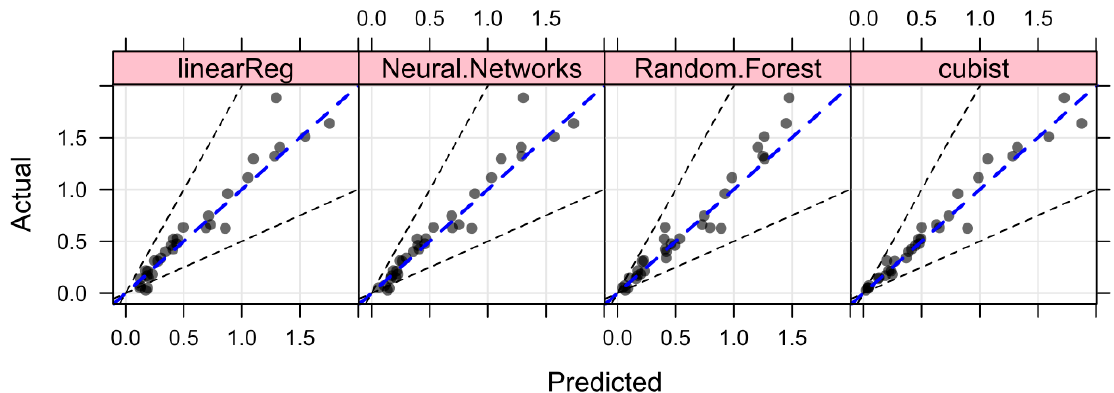
Figure 6. Error of the shear strength of RFM for the testing set. Table 2. The performance of di ff erent prediction models for test